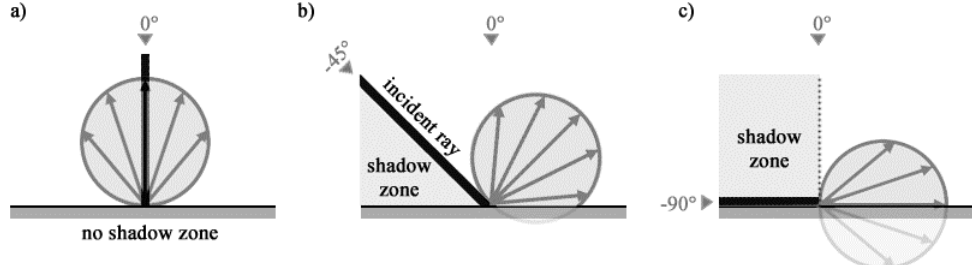
Figure 3. Oblique Lambert model. ( a ) Traditional Lambert directivity is generated when the angle of incidence is 0°. Correction factor = 1; ( b ) Oblique Lambert directivity is generated when the angle of incidence is within the interval (0°, ±90°). Correction factor within the interval (1, 2); ( c ) Oblique Lambert directivity is generated when the angle of incidence is ±90°. Correction factor = 2 [41].